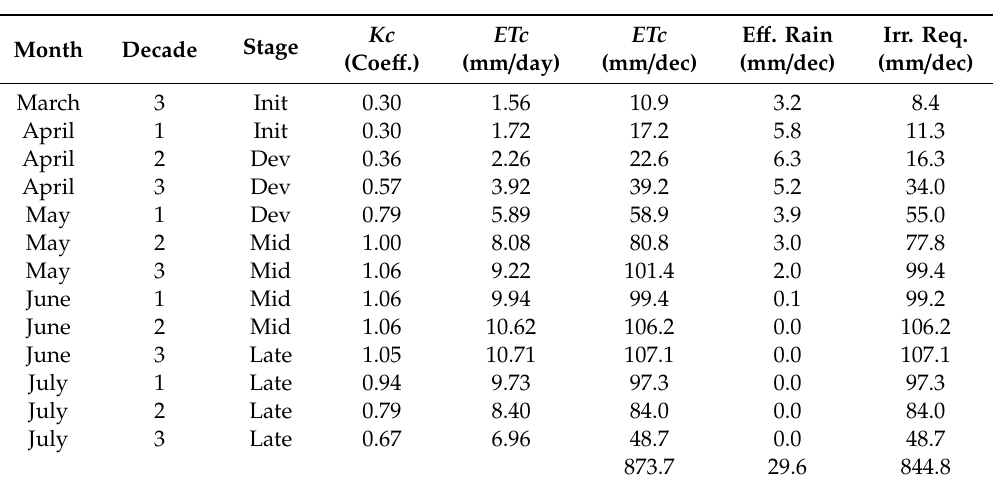
Table 5. Crop water requirement for white corn.